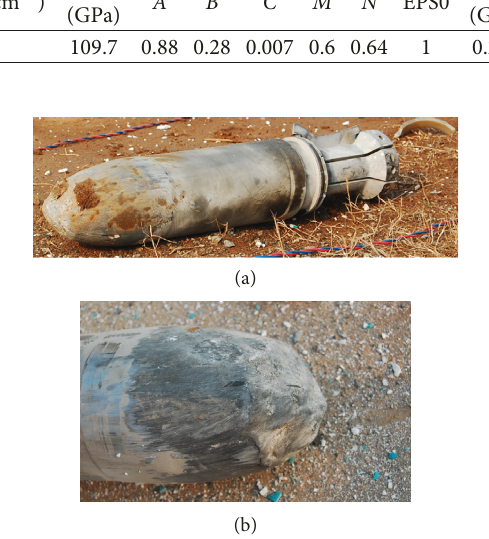
Figure 12: Damaged projectiles after penetrating: (a) projectile overall form after testing; (b) erosion of the projectile head after testing.